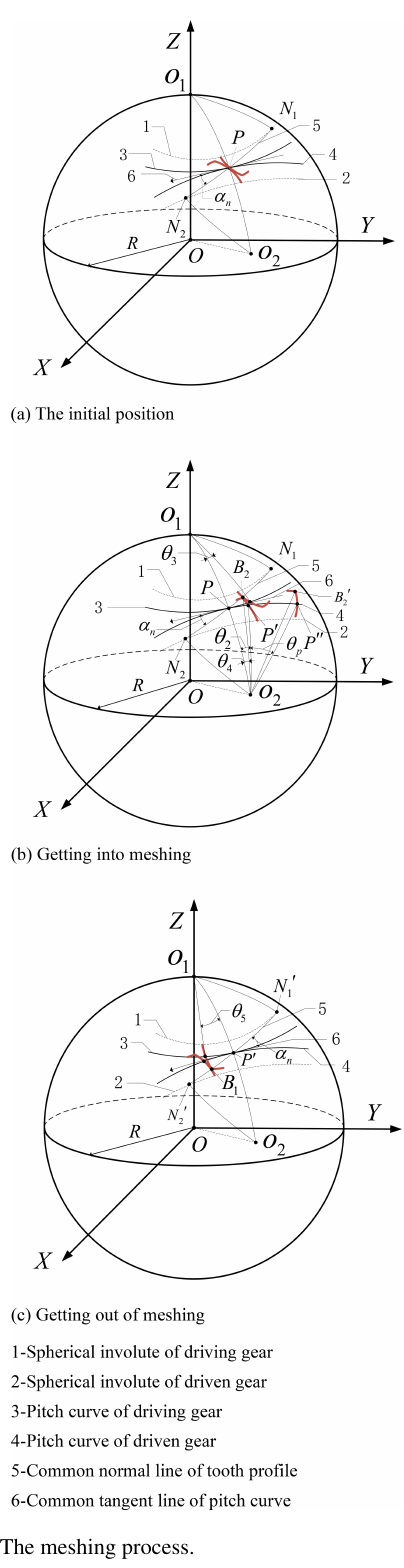
Figure 2. The meshing